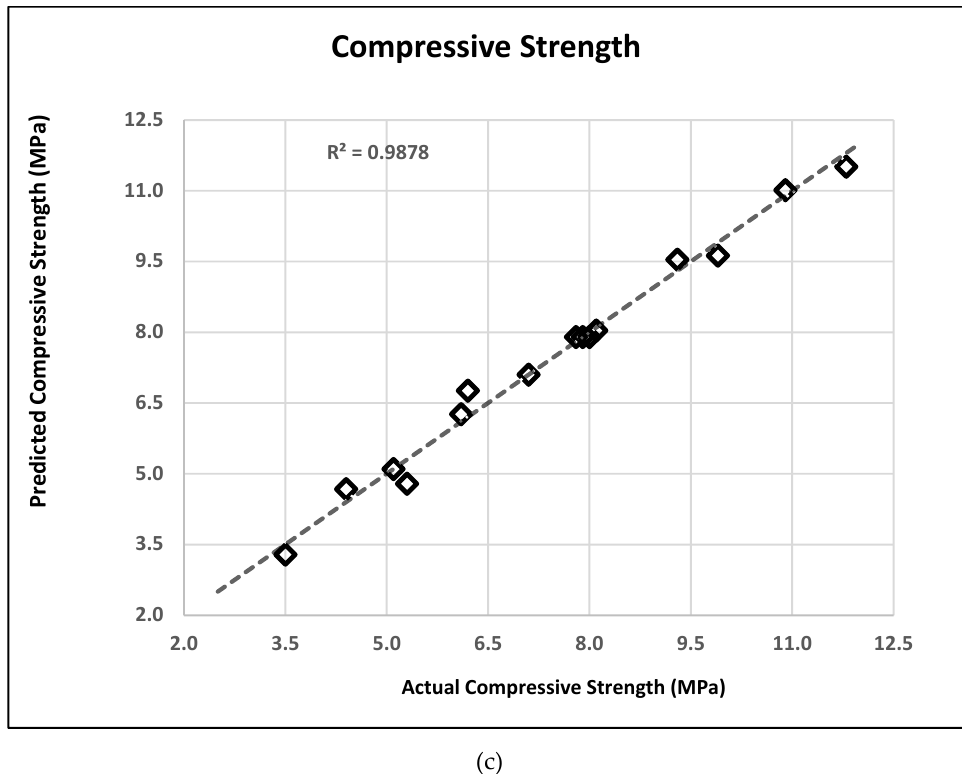
Figure 3. Relationship between experimental and predicted values of response variable.